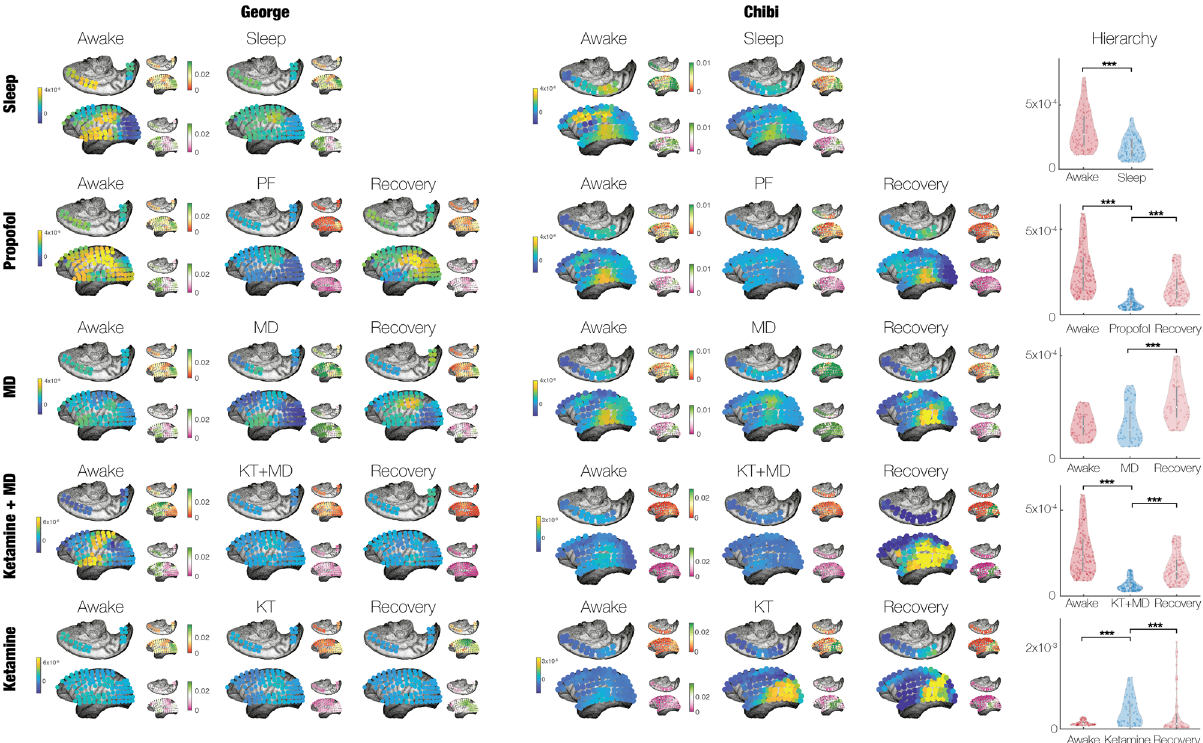
Fig. 4 Hierarchical signature of different brain states. We constructed a measure of hierarchy by estimating the variability of the non-equilibrium/non- reversibility of different brain states across space. For each condition, the row shows example renderings of the electrode-level non-equilibrium/non- reversibility for the two non-human primates (George and Chibi) who participated in all experimental conditions. The smaller inserts show how the level of reversibility is associated with the causal driving of the incoming FC in τ ð Þ and outgoing FC out τ ð Þ information captured by the shifted correlation (see Fig. 1 and Methods). The column shows the signi fi cant group-level results for the hierarchy of the inside out balance of intrinsic and extrinsic balance for all non- human primates with all sessions belonging to the speci fi c brain state (Wilcoxon rank-sum, p <